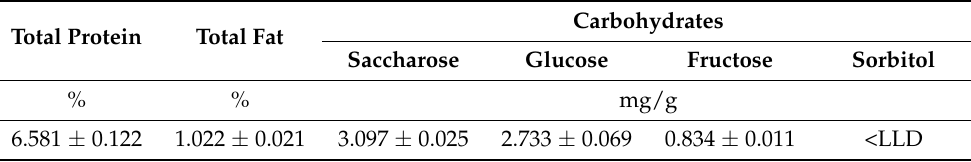
Table 3. Chemical composition of the botanical biogranulate (average ± SD). Total